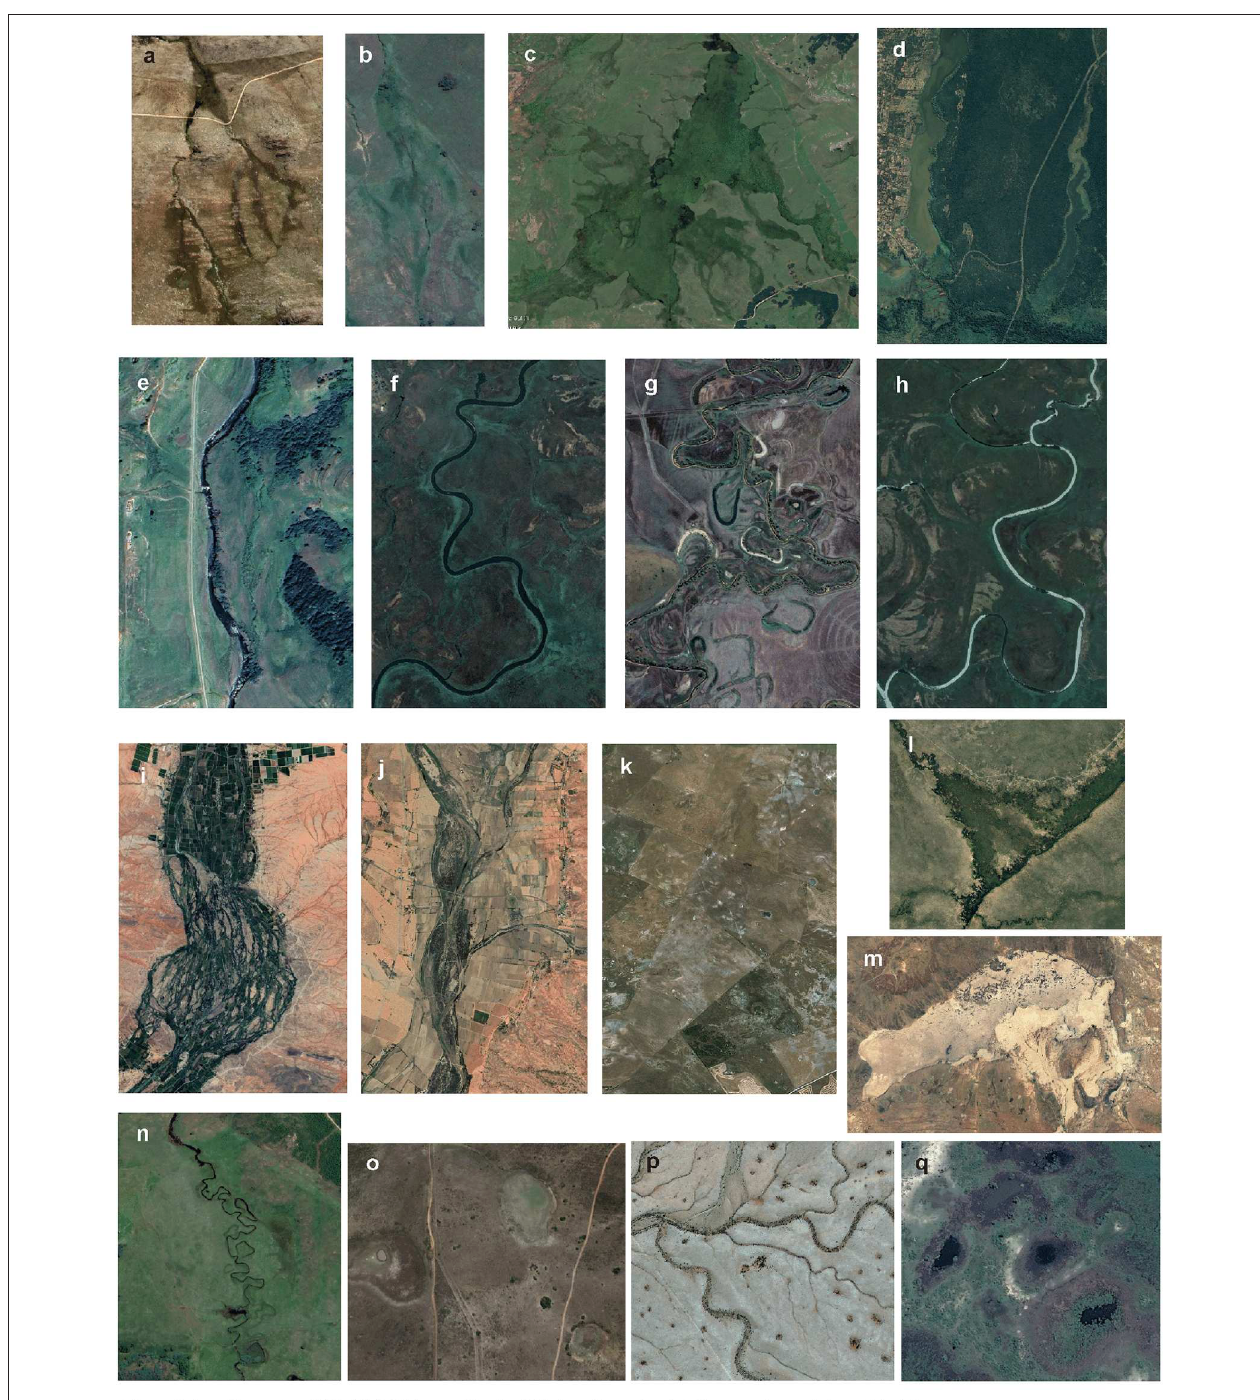
FIGURE 1 | Google Earth images of representative wetland types and sub-types, scale is variable to ensure visibility of features. (a) Hillslope seeps with and without stream, Swartberg, South Africa; (b) discontinuous valley-bottom, Mooi River catchment, South Africa; (c) unchannelled valley-bottom, Ntsikeni, South Africa; (d) blocked-valley depression, Muzi pan with Mkuze River towards south, South Africa; (e) straight river floodplain, Lotheni River, South Africa; (f) sinuous river floodplain, Okavango Delta, Botswana; (g) meandering river floodplain, Mzimvubu River, South Africa; (h) anastomosed river floodplain Okavango Delta, Botswana; (i) mixed bedrock-alluvial anabranching river floodplain, Orange River, South Africa; (j) wandering river floodplain, Olifants River, South Africa; (k) alluvial flat, Agulhas Plain, South Africa; (l) alluvial fan, Linyanti Swamp, Botswana; (m) aeolian depression, Verneukpan, South Africa; (n) subsidence depression, Dartmoor, South Africa; (o) redox depression, Shadowvlei, South Africa; (p) dissolution depressions, Ubib embayment, Namibia; and (q) margin-aggradation depression, Okavango Delta, Botswana.